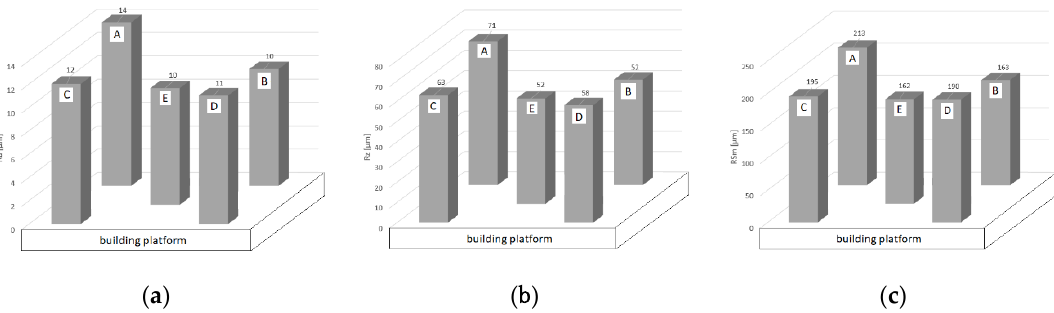
Figure 16. Distribution of roughness parameters in strategic positions on the build platform in ( a ) Ra, ( b ) Rz, and ( c ) RSm. ( b ) Rz, and ( c ) RSm.